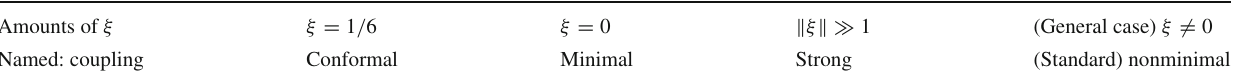
Table 1 Special values of the dimensionless coupling constant, (ξ) , in the nonminimal coupling and their names Amounts of ξ ξ = 1 / 6 Named: